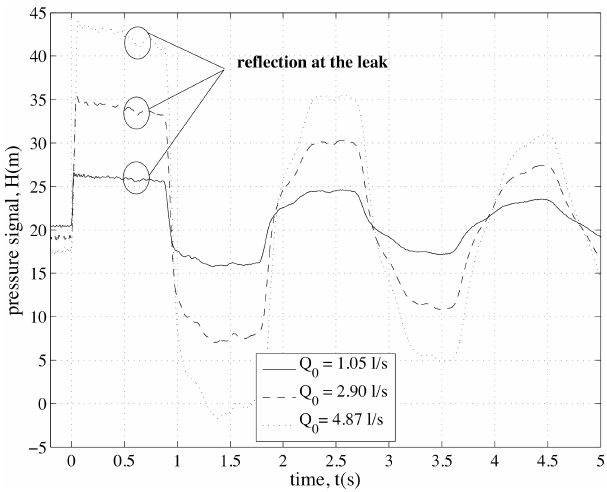
Figure 4. Damaged pipe with leak no. 1 (Table 1): pressure signal at section M for different values of the discharge at the end valve, Q 0 .